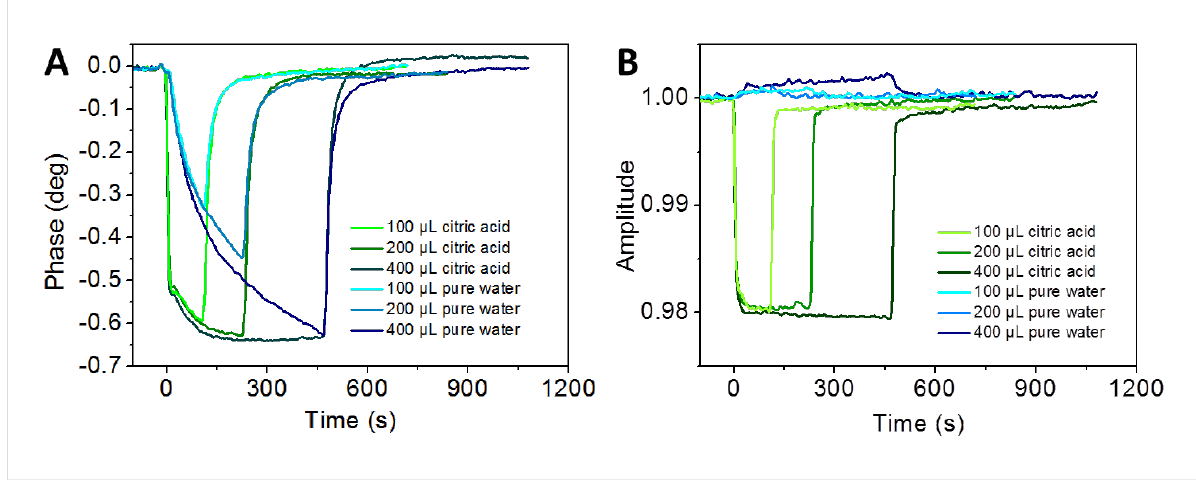
Figure 3: Monitoring of citric acid on calcium carbonate treated sensor surfaces. Phase (A) and corresponding amplitude (B) signal versus time for different injection volumes of 1 mM citric acid. Citric acid and pure water differ in their interaction with sensor chip surfaces in the presence of calcium